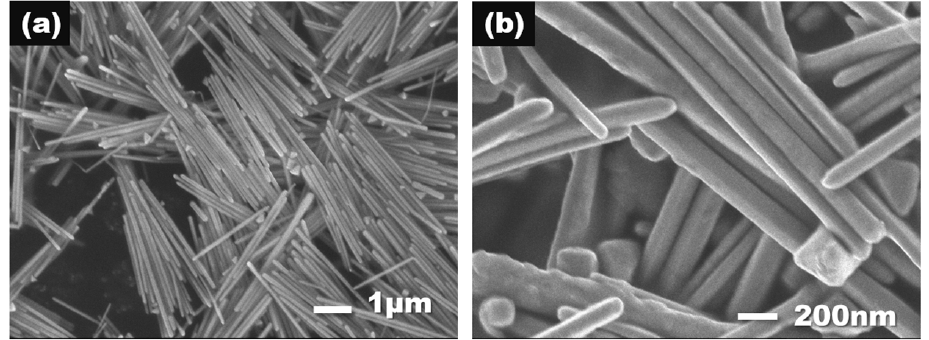
Figure 1. SEM images of ( a ) Ag nanowires (AgNWs) and ( b ) aminated Ag nanowires (A-AgNWs).